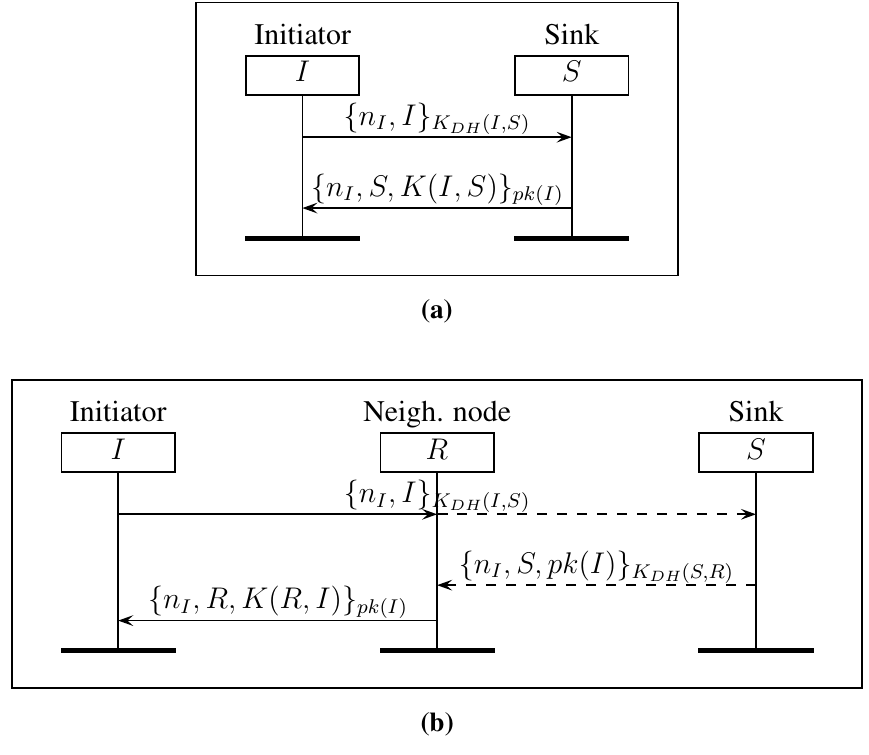
Figure 1. Join protocols. ( a ) DJS: direct join to the sink. Node I directly joins the network by communicating directly with the sink S . ( b ) IJS: indirect join to the sink. Intermediate nodes between R and S forward messages without any encryption or